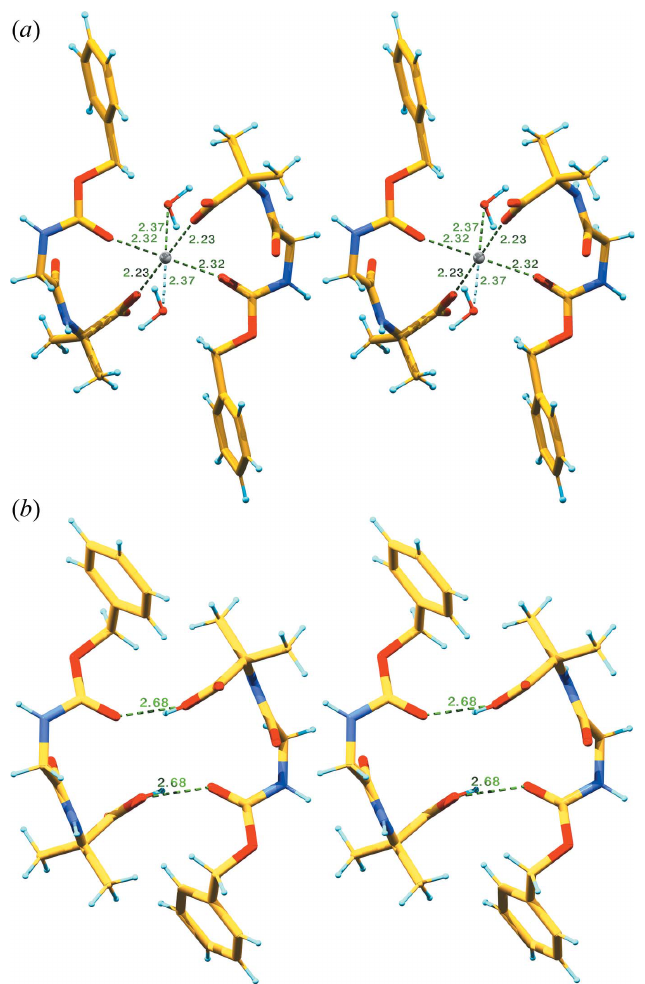
Figure 2 Wall-eyed stereo figure of two inversion-related molecules of the metal- bound structure I ( a ) with the Ca 2+ ion in grey and the free, neutral dipeptide II ( b ). Distances for the Ca 2+ co-ordination ( a ) and hydrogen bonds ( b ) are shown in A˚ .